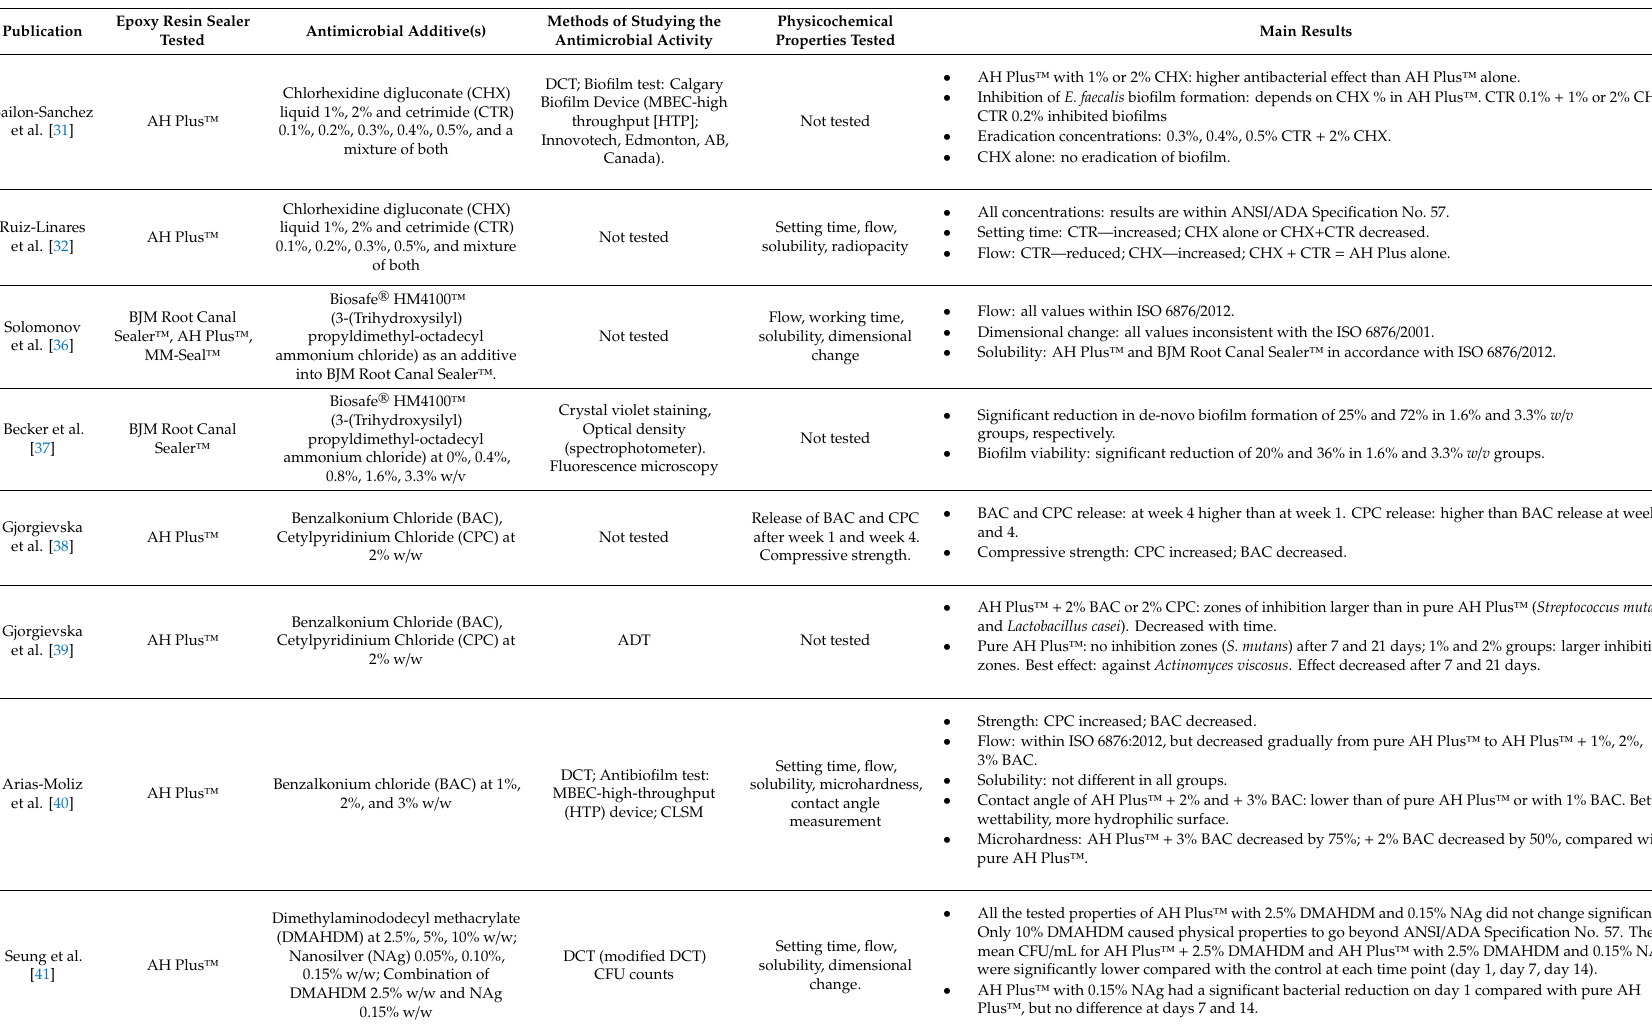
Table 3. General characteristics of studies included in this